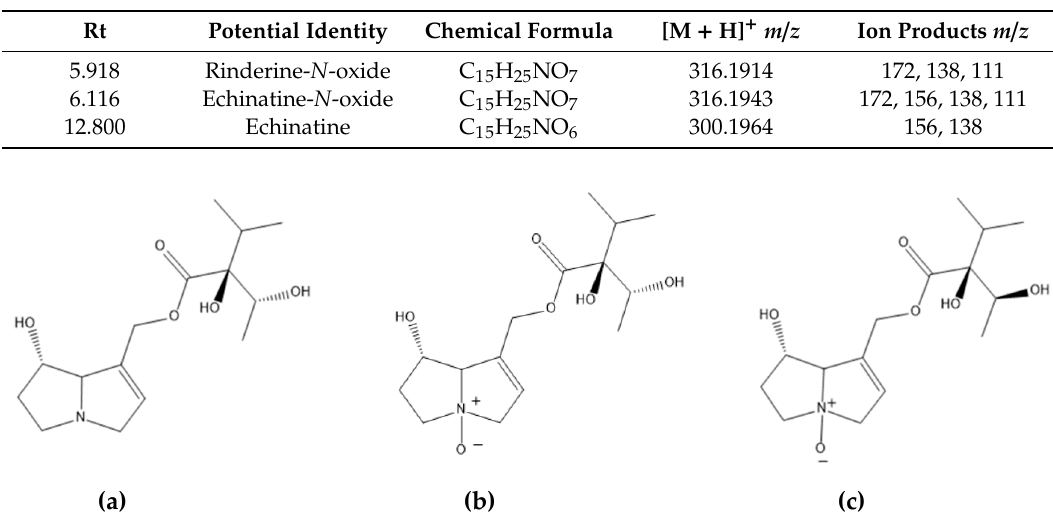
Table 2. LC/MS analysis of PAs extract of R. graeca.